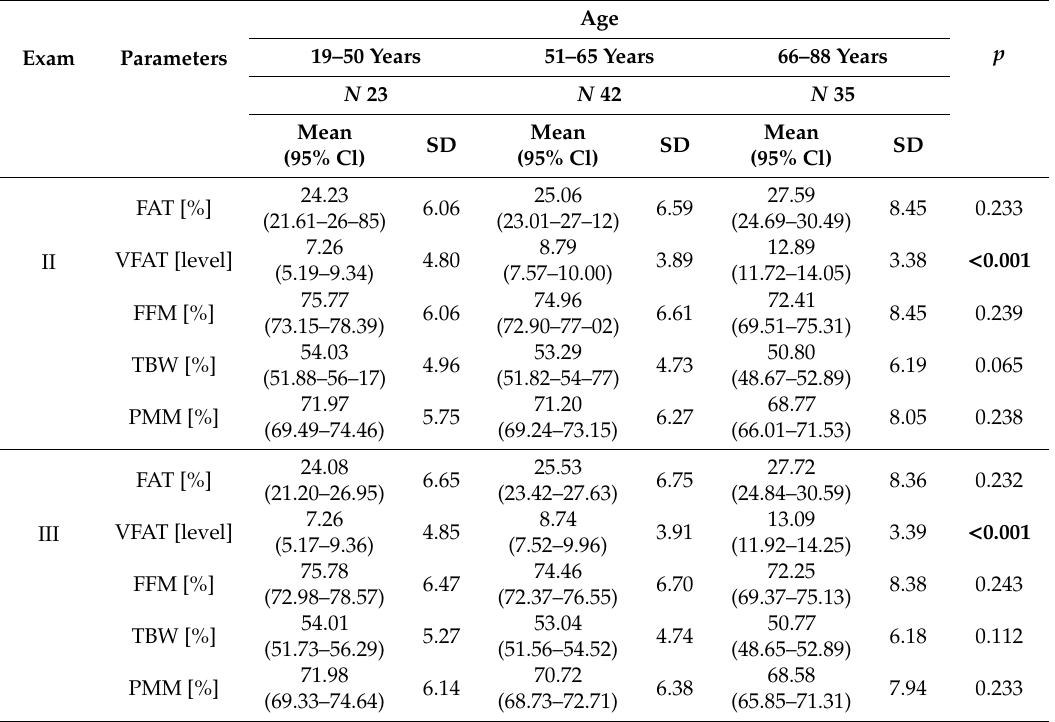
Table 1. Body mass components versus subjects’ sex.